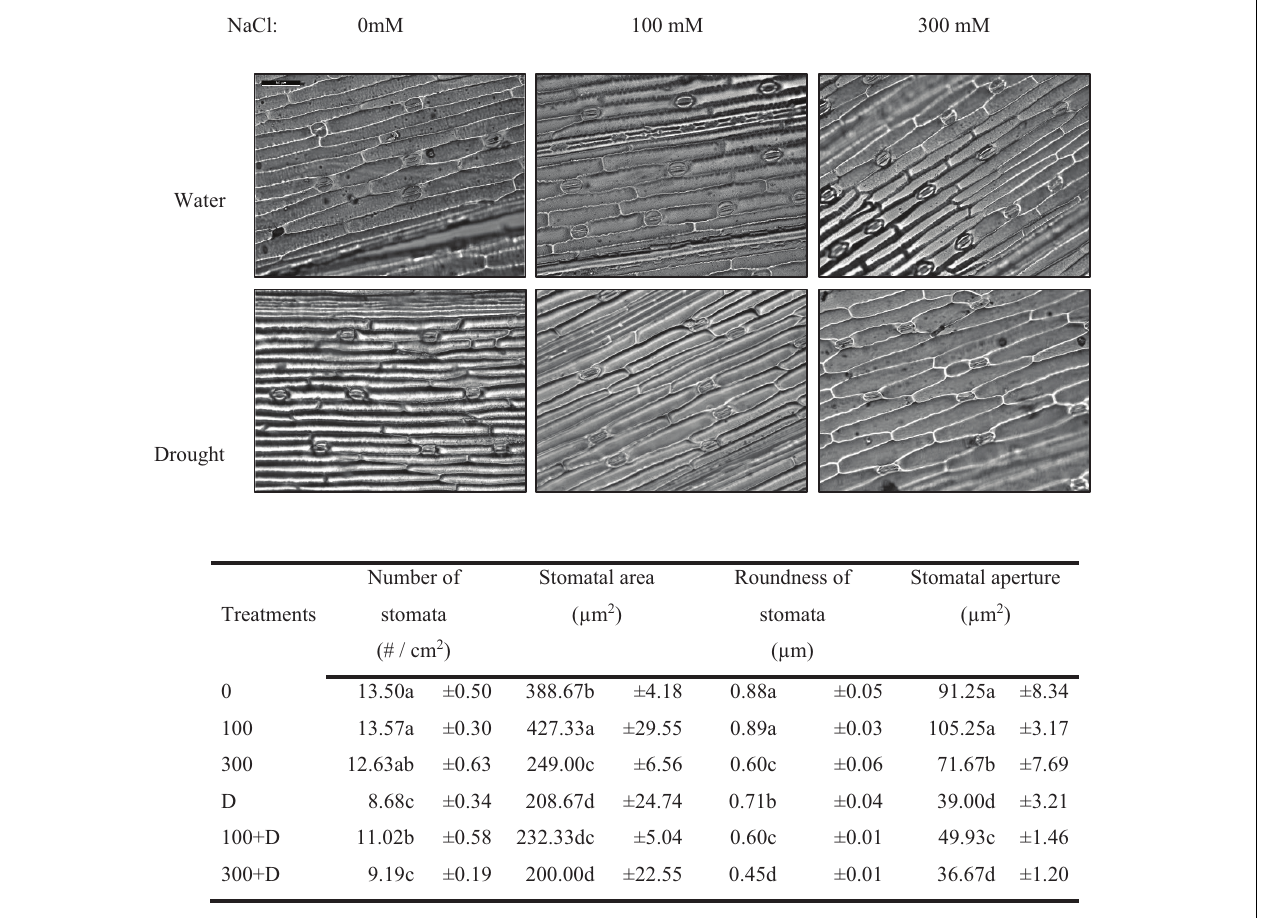
FIGURE 6 | Stomatal morphometric characteristics of Panicum antidotale . Changes in the number of stomata, stomatal area, roundness of stomata, and area of the stomatal aperture for treatments of 0, 100, and 300 mM NaCl, drought (D), and a combination of salinity with drought [100 and 300 mM NaCl + drought (100 + D and 300 + D, respectively)] are shown. Different letters denote, after Bonferroni post hoc test, significant difference ( P <